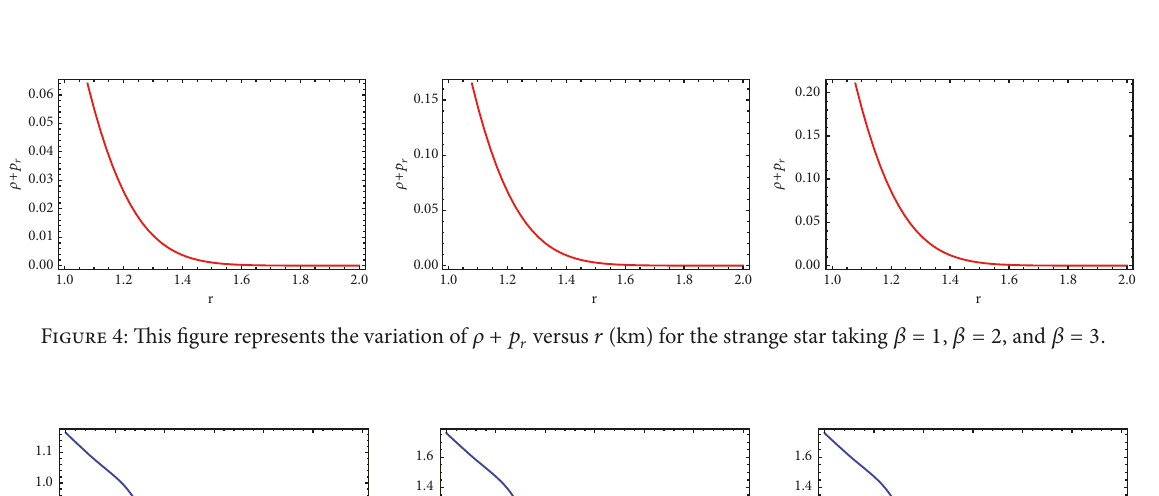
Figure 3: This figure represents the variation of 𝜌 + 3𝑝 𝑟 versus 𝑟 (km) for the strange star taking 𝛽 = 1 , 𝛽 = 2 , and 𝛽 = 3 .